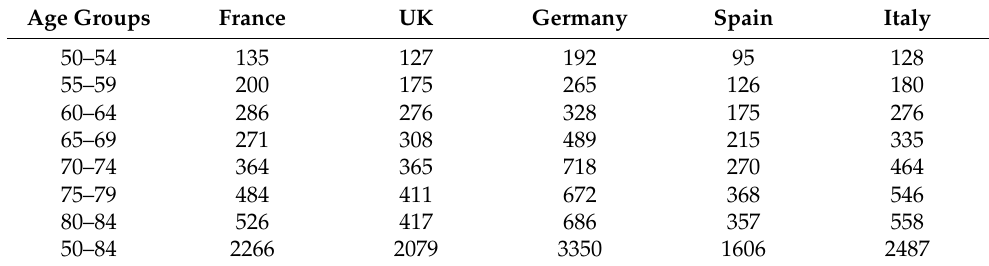
Table 1. Number of women with osteoporosis (by 1000) in some European countries (from ref. [10]). Age